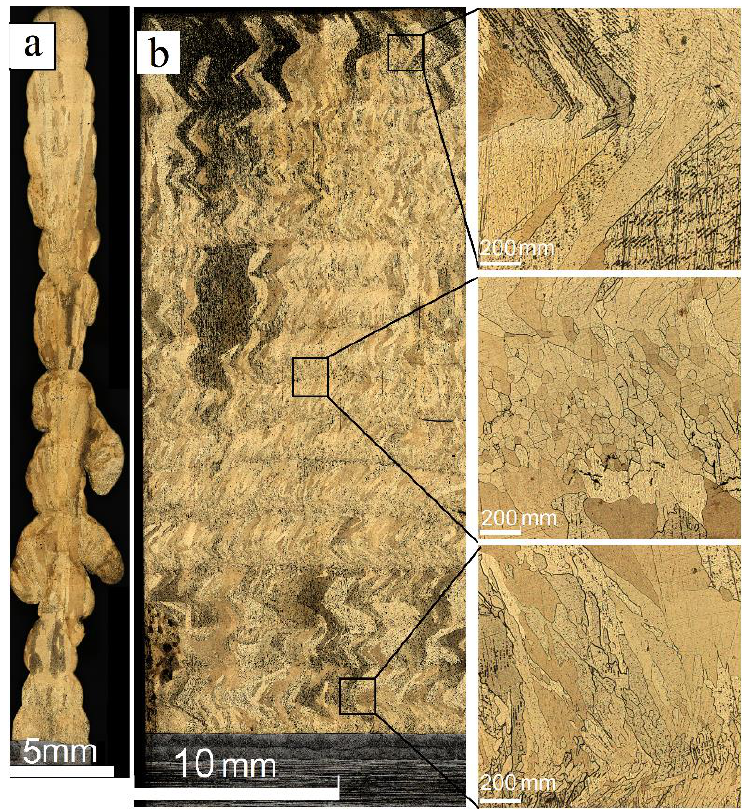
Figure 3. Profile ( a ) and front ( b ) cross section optical views of the Cu-7.5wt.%Al wall obtained at heat input of 0.21 kJ/mm.